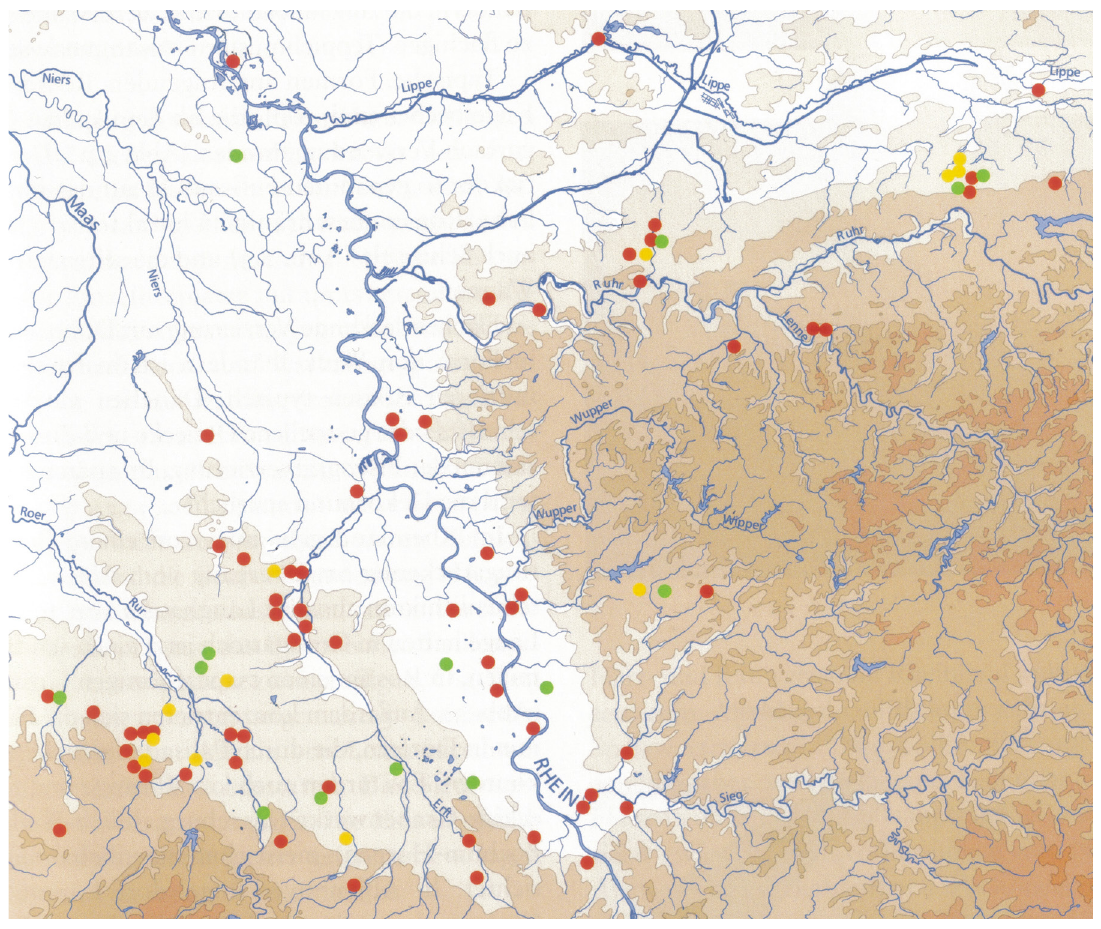
Figure 1: Middle Neolithic settlements in North Rhine-Westphalia: Green: GG; Yellow: GG/RÖ; Red: RÖ (after Arora et al. 2010: 67, Fig.